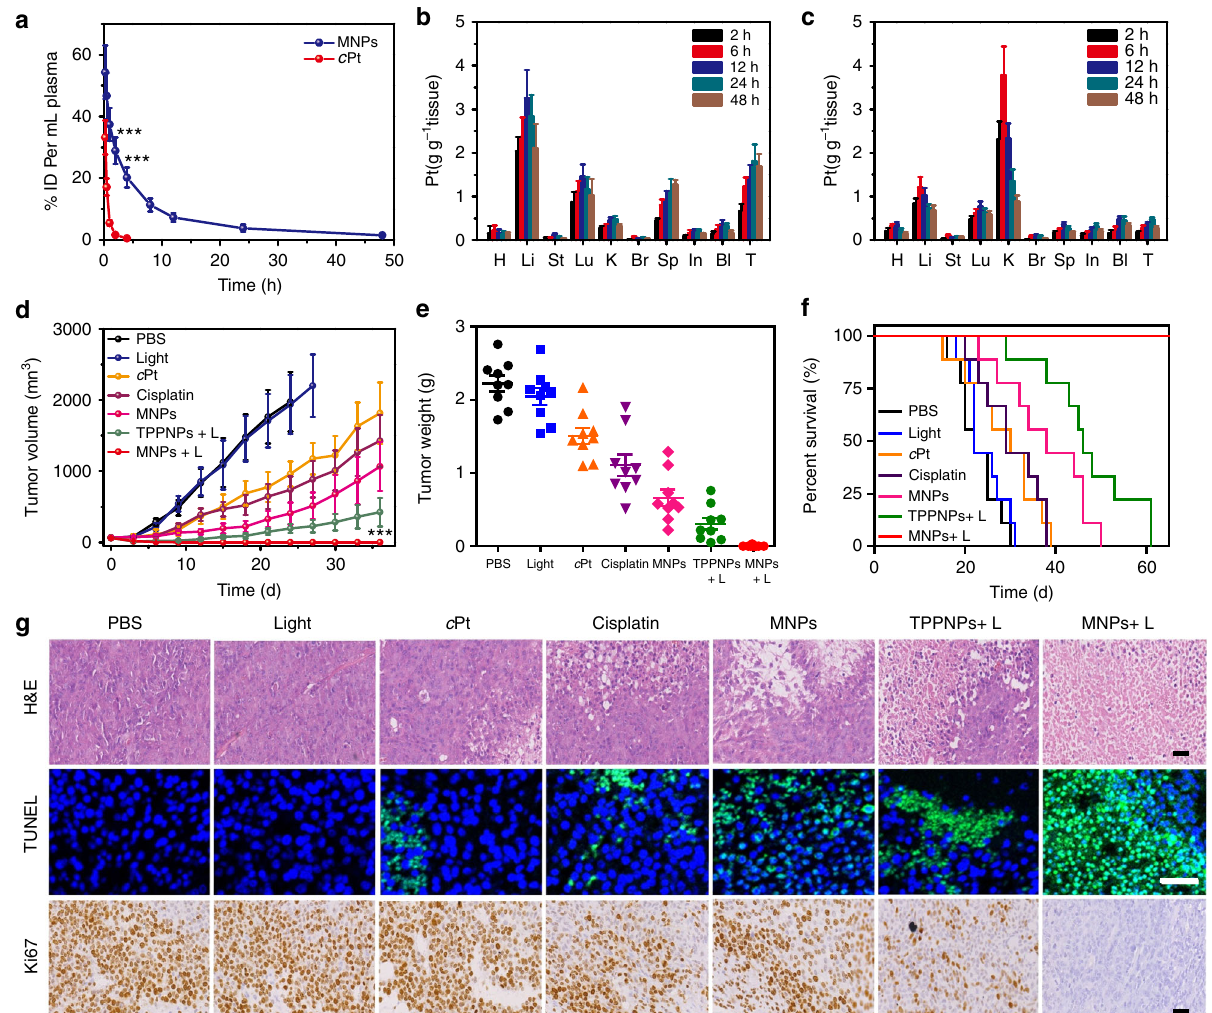
Fig. 5 In vivo synergistic anti-tumor effect. a Plasma platinum concentration versus time after injection of c Pt and the MNPs (2 mg Pt per kg) ( n = 4). Biodistributions of Pt at different time points after injection of b MNPs and c c Pt (2 mg Pt per kg) ( n = 4). H heart, Li liver, St stomach, Lu lung, K kidney, Br brain, Sp spleen, In intestine, Bl bladder, T tumor. d Tumor growth curves for the mice after different formulations ( n = 9). e Weight of U87MG tumors from the mice received different formulations. f Kaplan – Meier plots of the mice bearing U87MG tumors after treatment with different formulations. The irradiation density was 0.3 W cm – 2 at 671 nm, and the irradiation time was 10 min. g H&E, TUNEL, and Ki67 staining of tumor tissues collected from the mice administrated with various formulations. Scale bar is 100 μ M. The data are expressed as means ± s.d., *** P